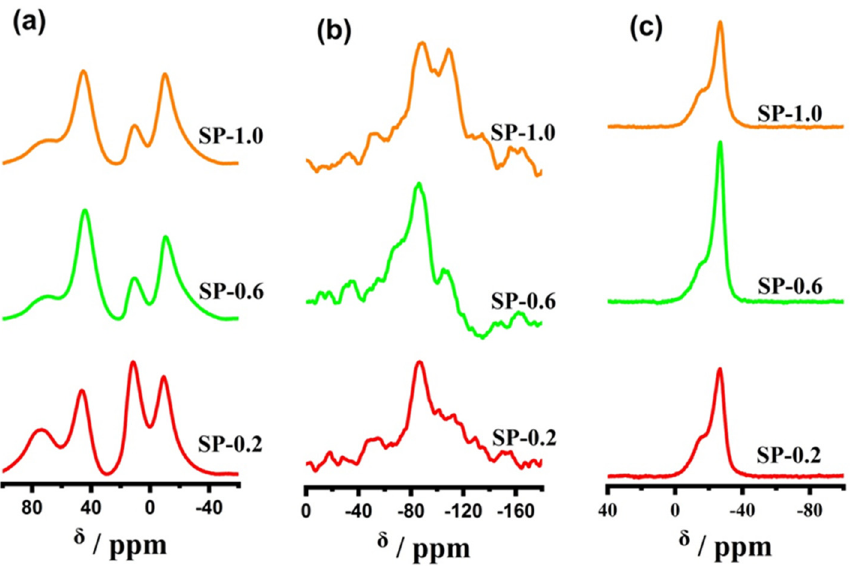
Figure 5. ( a ) 27 Al; ( b ) 29 Si NMR; ( c ) 31 P spectra of as-synthesized SAPO-34